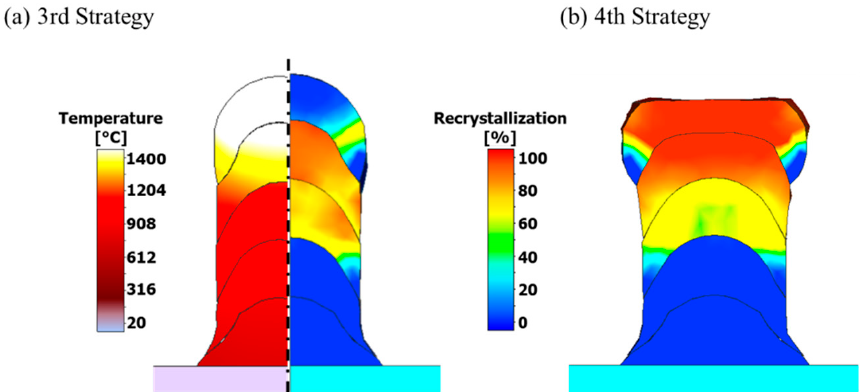
Figure 8. ( a ) distribution of temperature and fraction of recrystallization for the 3rd strategy, ( b ) fraction of recrystallization for the 4th strategy. The displayed state for both strategies is at the same time step after the completed welding and forming.